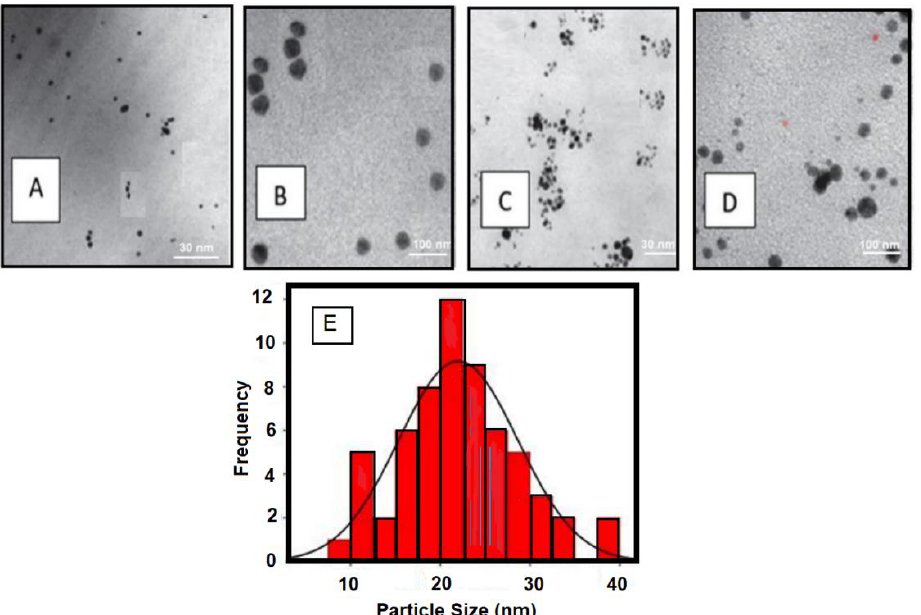
Figure 2. TEM for S1Ag 0.3 ( A , B ) and S1Ag0.8 ( C , D ) at Magnification (30 k and 100 k) and ( E ) DLS of the Synthesized Silver Nanoparticles.